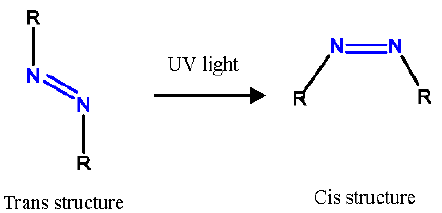
Figure 2. Light effect for the trans-cis isomerization mechanism of ADVN.